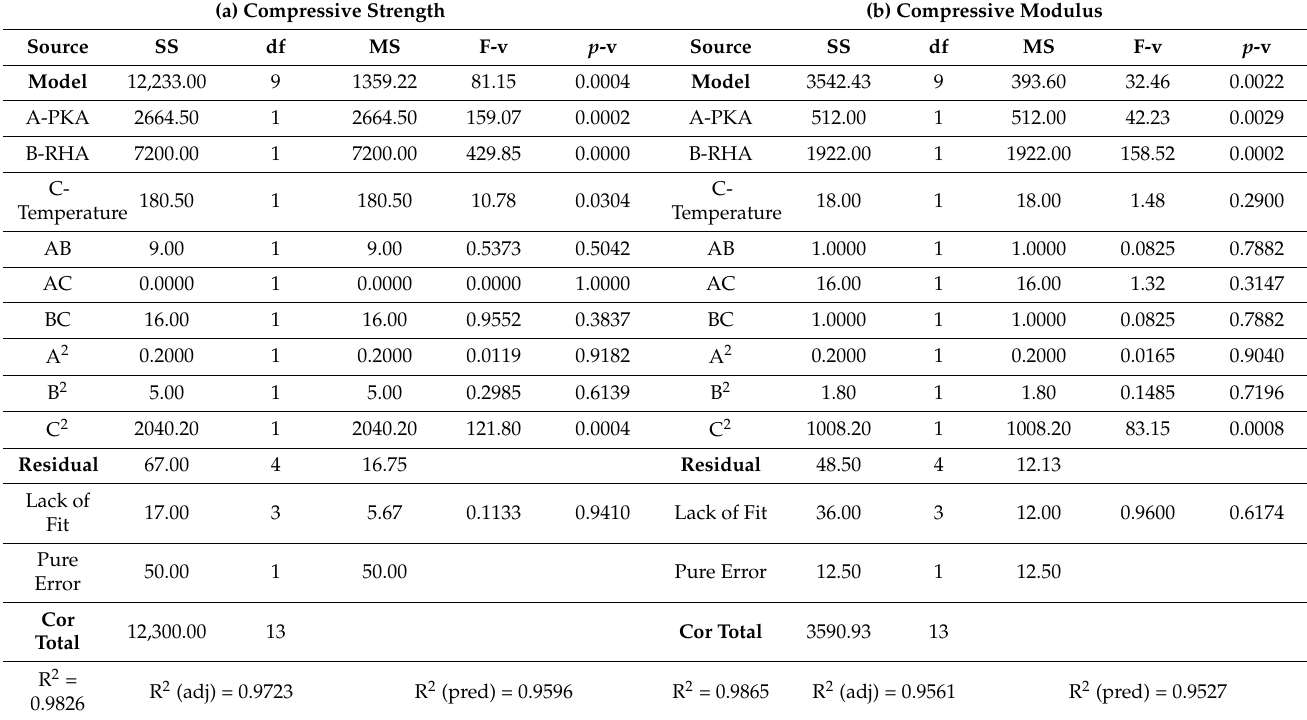
Table 8. Analysis of variance for (a) compressive strength (b) compressive